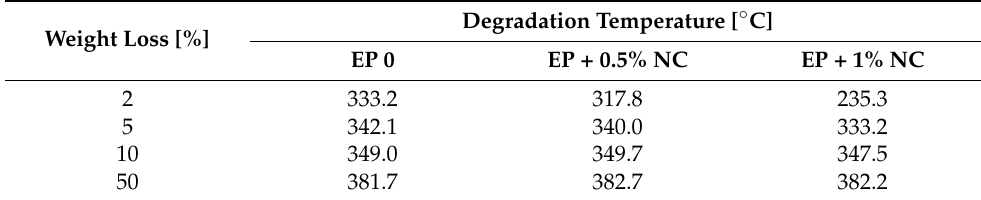
Table 5. Weight loss in NC composites at different temperatures.